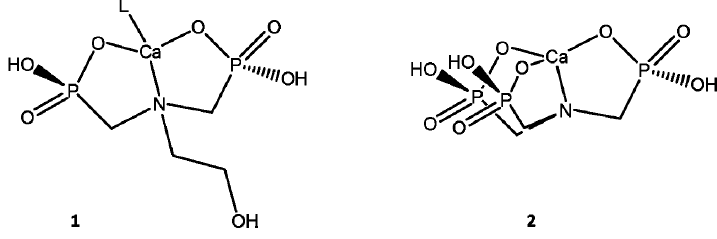
Figure 8. Chelate rings formed when (1) HMPA inhibitor and (2) ATMP inhibitor were 50%